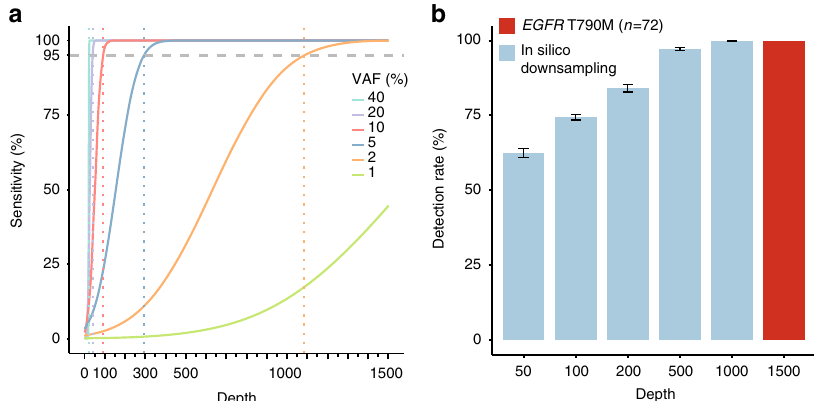
Fig. 3 Impact of sequencing depth on single nucleotide variant (SNV) detection. a Limit of detection (LOD) is de fi ned as the VAF for which 95% sensitivity is achieved for a given depth (Methods section). On the asis of subsampling analysis of computational mixture data, the LOD of 2% is achieved at 1085×, 5% at 294×, 10% at 94×, 20% at 40×, and 40% at 18×. b 72 samples harboring EGFR T790M were down-sampled from the original depth, and detection rates were measured at each depth (10 iterations), assuming that all variants were identi fi ed with the full data (1500×). Detection rate for this variant is < 75% even for 100× data. Error bar: s.e.m